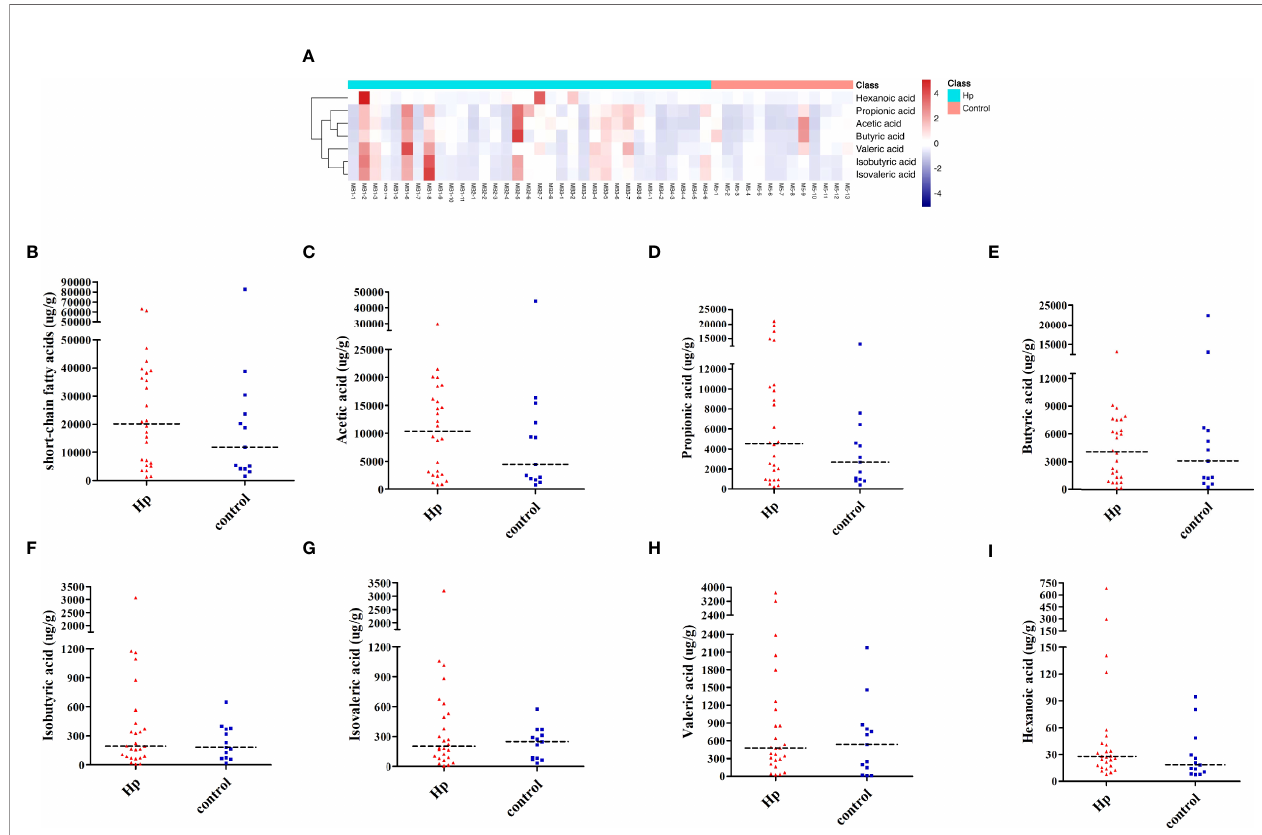
FIGURE 3 | Analysis of SCFAs in H. pylori -positive patients and normal controls. (A) Heatmap of SCFA differences across different samples in H. pylori -positive and normal control groups. The quanti fi cation of total SCFAs (B) , acetic acid (C) , propionic acid (D) , butyric acid (E) , isobutyric acid (F) , isovaleric acid (G) , valeric acid (H) , and hexanoic acid (I) in the H. pylori -positive patients and normal control groups. Hp: H. pylori -positive; Control: H. pylori